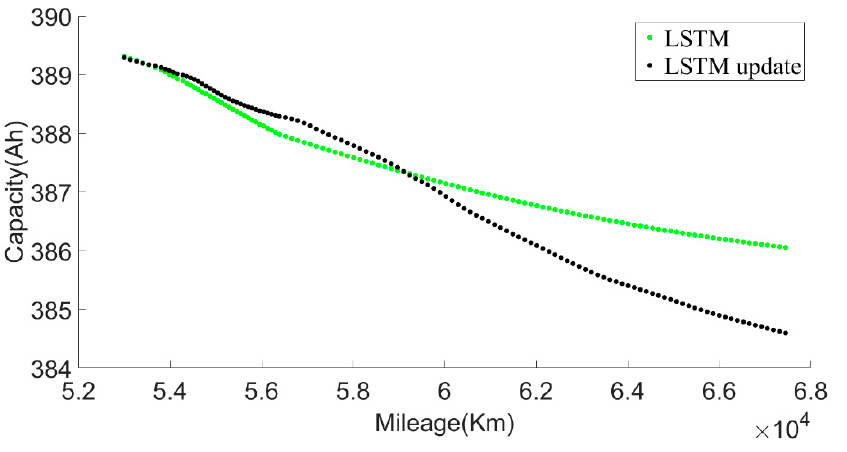
Figure 31. Comparison of prediction results before and after LSTM update.